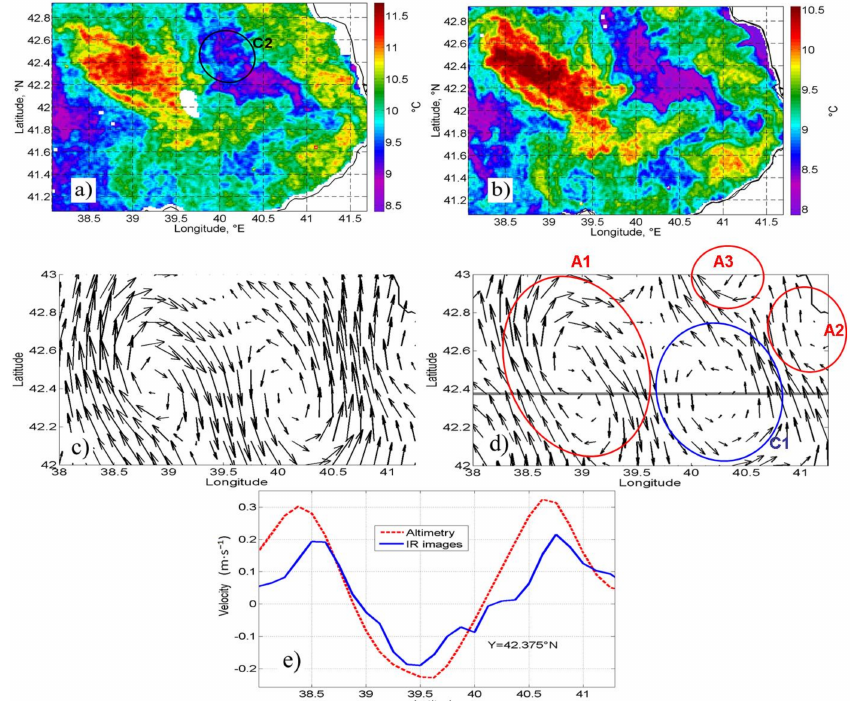
Figure 3. ( a , b ) AVHHR SST at 11 January 2007 19:40 ( a ), 12 January 2007 07:56 ( b ); ( c , d ) Surface current calculated for 12 January 2007 from altimetry ( c ), from IR images (solid line—section) ( d ); ( e ) meridional section of u (red line—altimetry; blue—IR